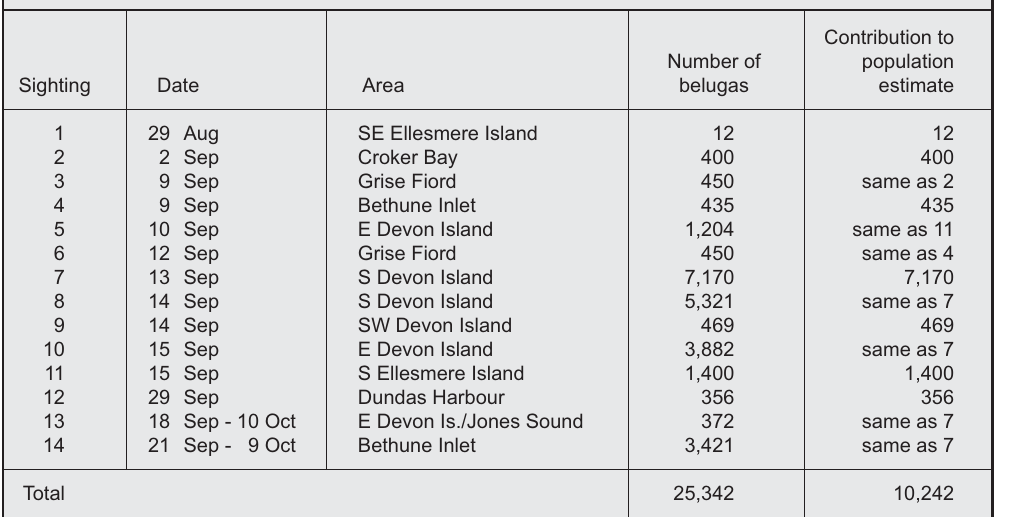
Table 7. Summary of beluga sightings in the Canadian High Arctic during fall migration, 1978. See Fig. 10B for sighting